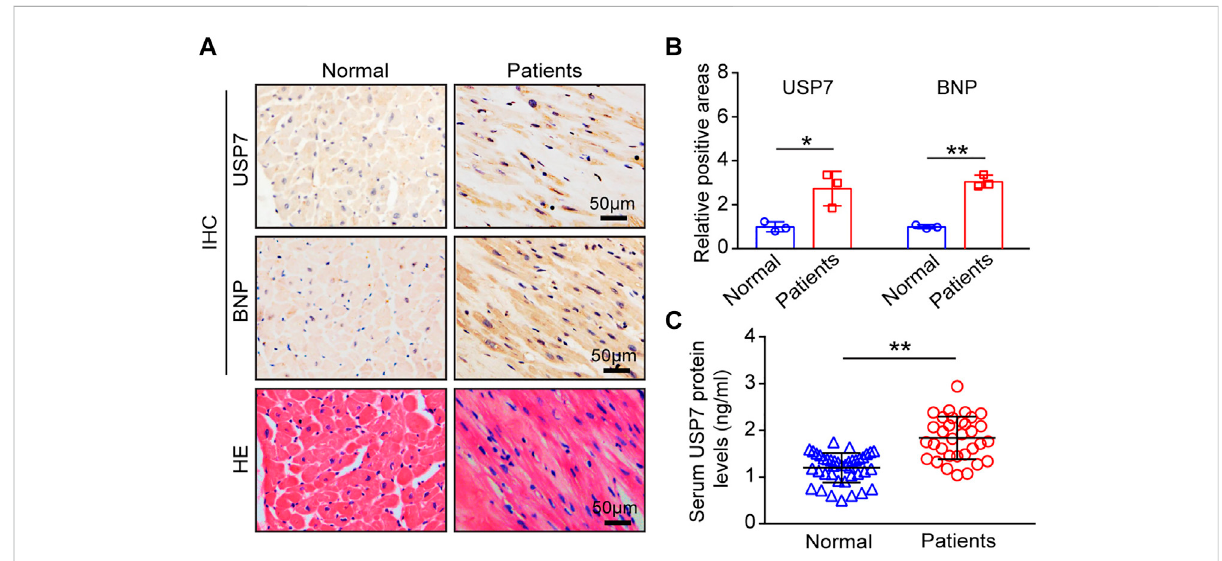
FIGURE 1 USP7wasoverexpressedinpatientswithheartfailure. (A,B) Immunohistochemical(IHC)stainingofUSP7(upper)andBNP(lower)proteinsinthe heart tissues from normal control and HF patients (left). Scale bars, 50 μ m. Quanti fi cation of the relative USP7- and BNP-positive areas (right; n = 3). (C) The concentration of USP7 protein level in serum from normal controls ( n = 37) and patients with HF ( n = 33) was detected by ELISA assay. The data are presented as the mean ± SD, and n represents the number of animals per group. * p < 0.05, and ** p <